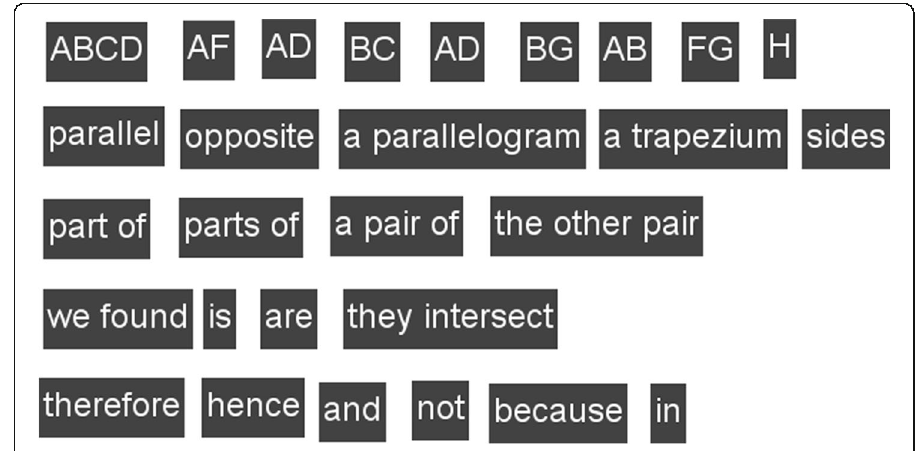
Fig. 8 Tiles for constructing formal